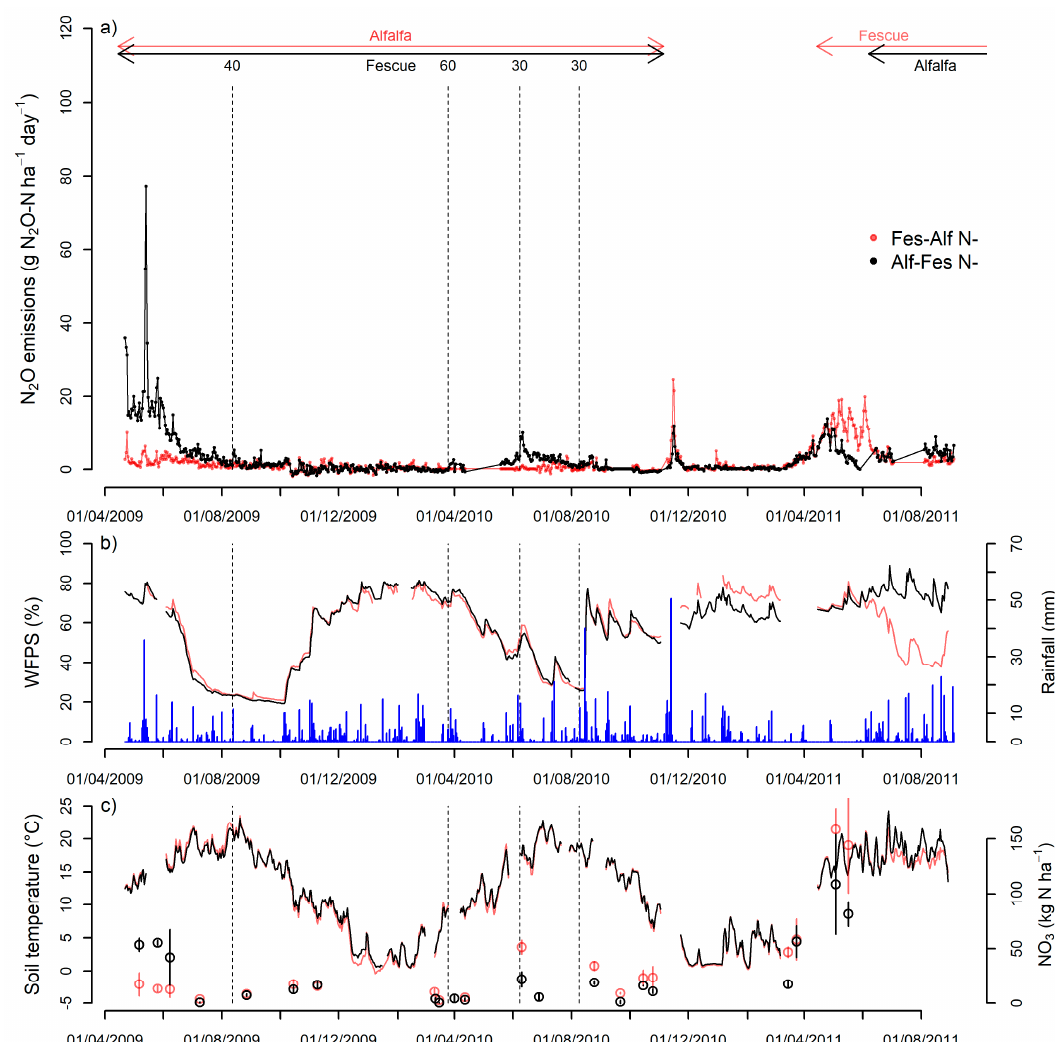
Figure 4. Daily N 2 O emissions ( a ); daily rainfall and WFPS (0–30 cm) ( b ); and daily soil temperature (15 cm) and soil nitrate content (0–30 cm) ( c ) under semi-perennial crops: Fes-Alf N − (green) and Alf-Fes N − (red). Each point in ( a ) represents a measured value (daily average for the treatment). Vertical dotted lines represent fertilization events with the N rate in kg N ha − 1 . Horizontal arrows in ( a ) indicate the crop duration (between sowing and crop destruction). Vertical lines in ( c ) represent the standard deviations for soil nitrate content. See Table 1 for treatment abbreviations.